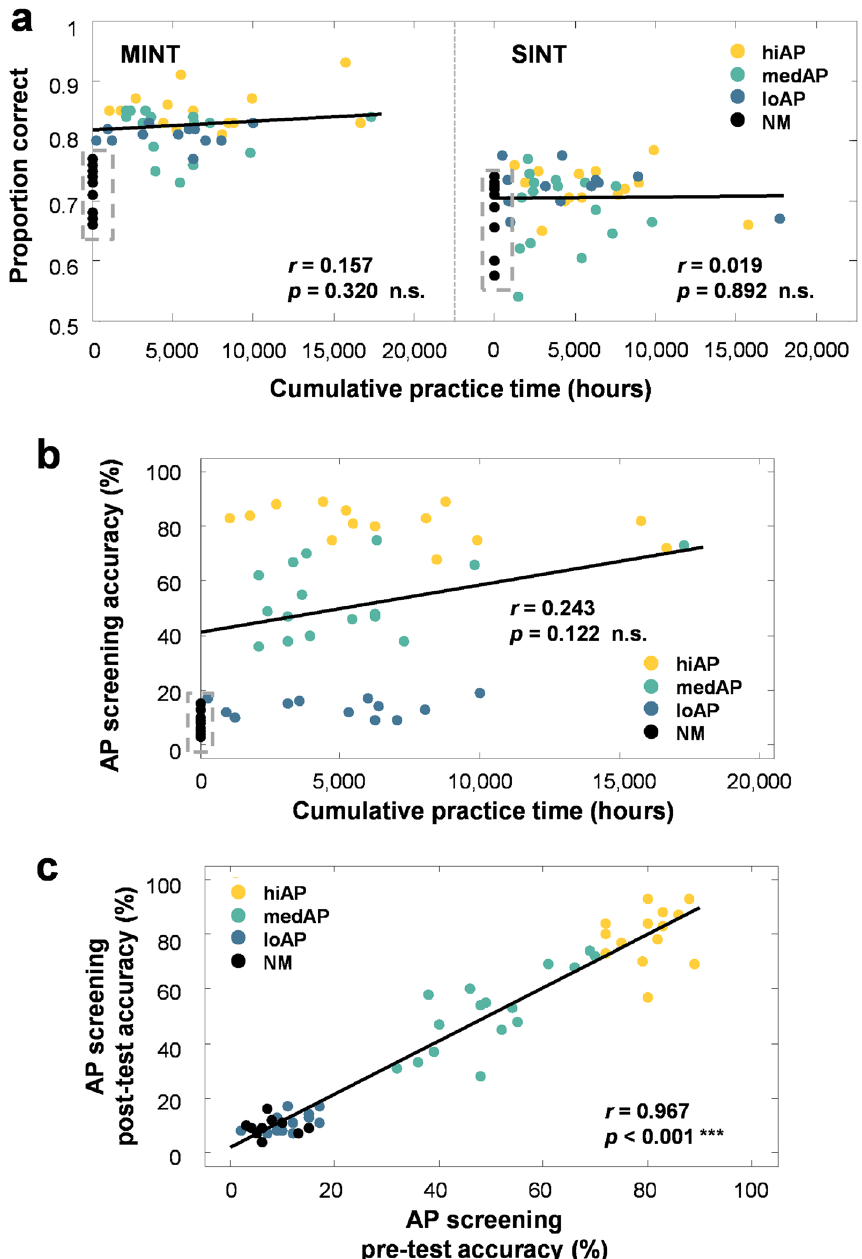
Figure 6. Correlations of cumulative practice hours and screening scores on MINT and SINT performance. ( a ) Scatterplots depict correlation between cumulative practice hours (computed from MMHQ) for music-in- noise task (left panel) and speech-in-noise task (right panel). ( b ) Correlation between AP screening score and cumulative practice hours. Note that non-musicians (black dots) were excluded from this analysis due to non- applicable training hours. ( c ) Correlation between AP screening score for pre and post-testing session. Each dot represents individual subject with quasi-AP proficiency level coded by different